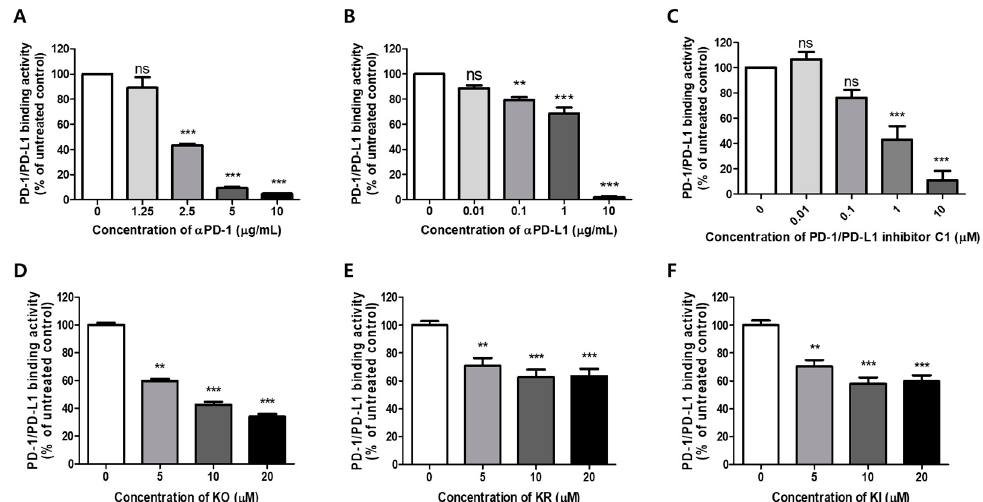
Figure 2. Effects of KO and its glycosides on programmed cell death protein 1 (PD-1)/PD-1 ligand-1 (PD-L1) protein interaction in a competitive ELISA. ( A ) PD-1 neutralizing antibody, ( B ) PD-L1 neutralizing antibody, ( C ) PD-1 / PD-L1 inhibitor C1, ( D ) KO, ( E ) KR, and ( F ) KI were pre-treated onto plates coated with PD-L1, followed by incubation with biotinylated PD-1. Relative PD-1 / PD-L1 binding activities were determined using a competitive ELISA assay, as described in the Materials and Methods. Data are presented as means ± S.E. (standard error) values of three independent experiments. Asterisks indicate significant inhibition of PD-1 / PD-L1 binding activity by each test inhibitor as compared with the control group. (** p < 0.01, and *** p < 0.001; ns: not significant).